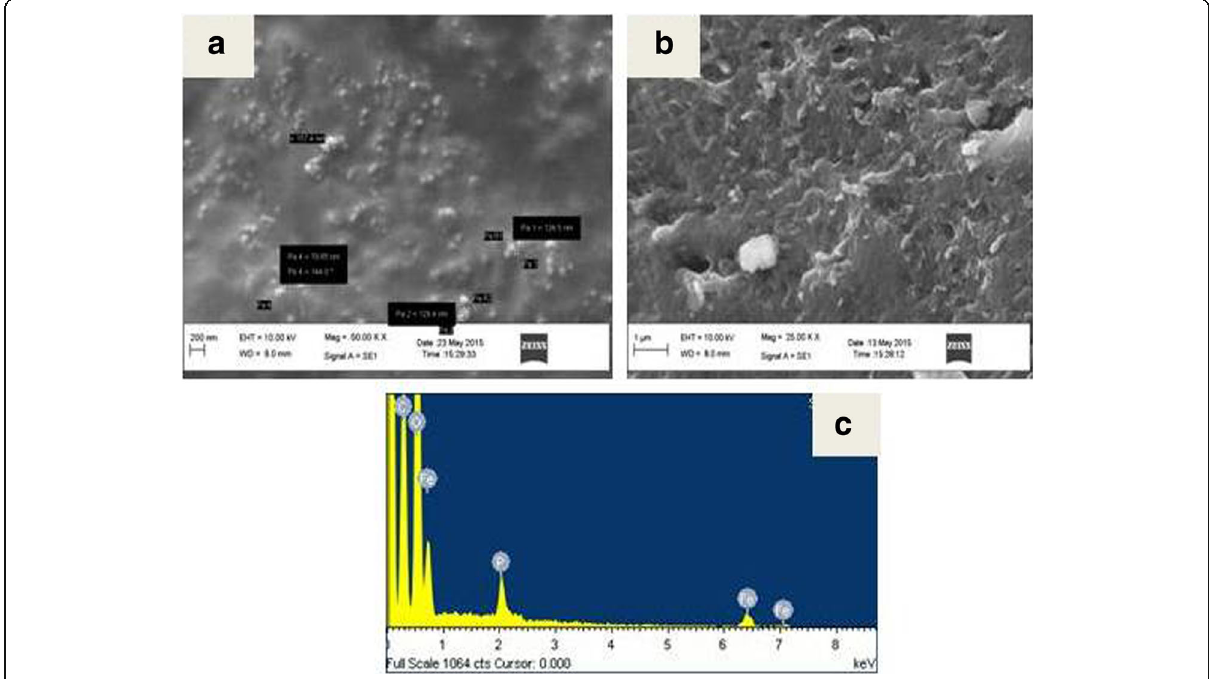
Fig. 4 SEM image of a ZVIN, b sorbent, and c EDX image of